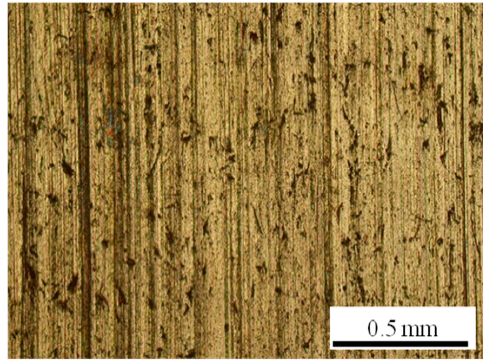
Figure 8. Optical micrograph of the of the worn surfaces.